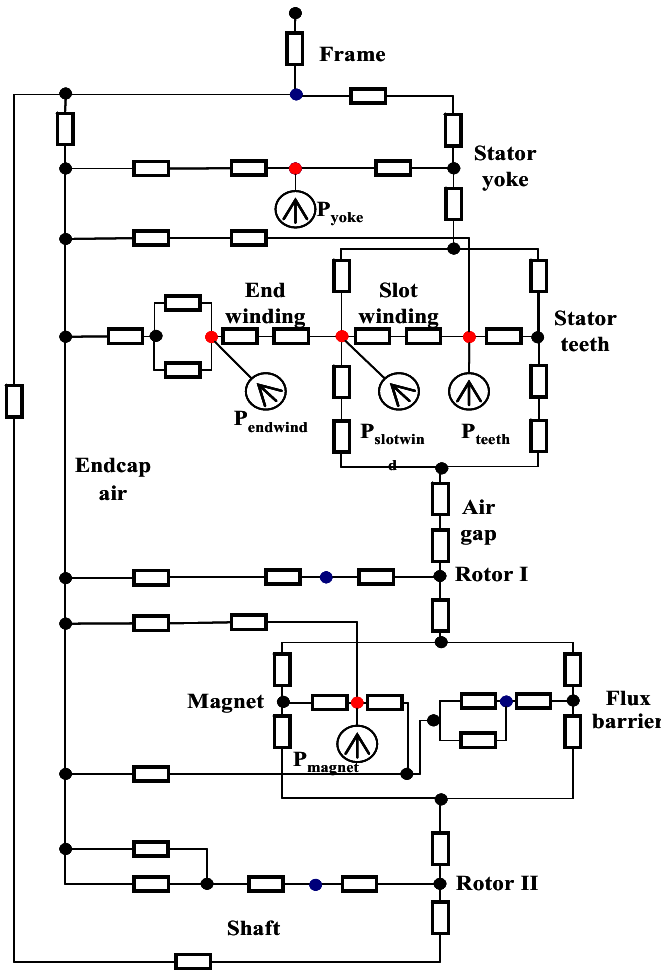
Figure 11. Thermal equivalent circuit.